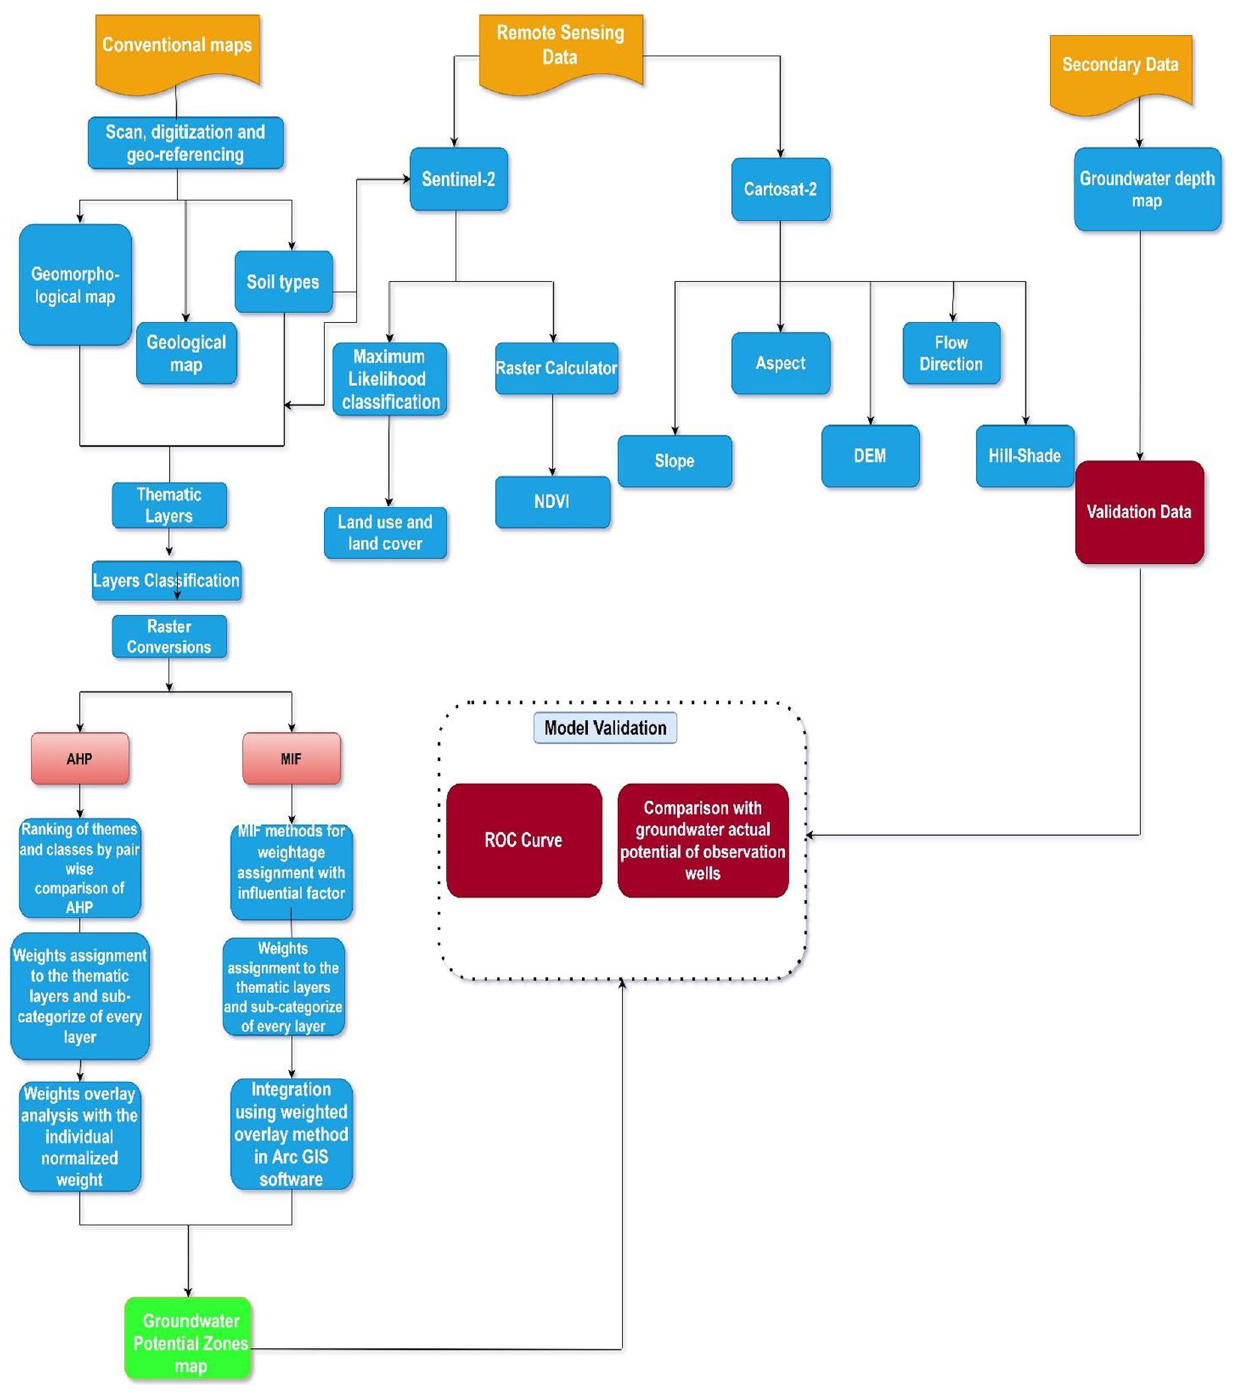
Fig. 2 Flowchart of methodology of the study